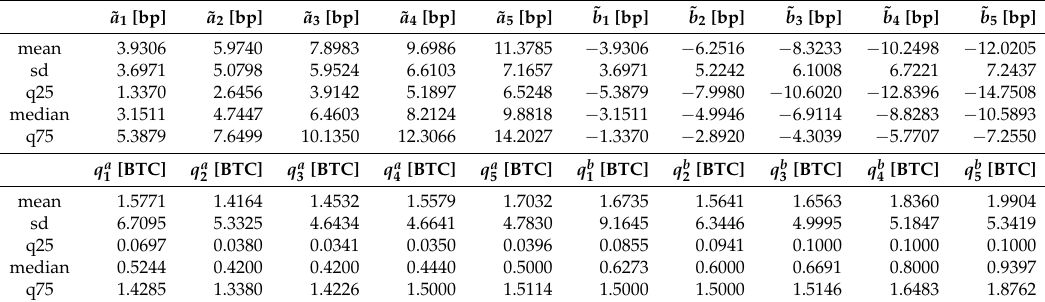
Table A2. Descriptive statistics of the average order book for the Bitstamp BTC/USD market. The table reports descriptive statistics for the relative prices (˜ a i and ˜ b i ) and depths ( q a the first five limit order steps.